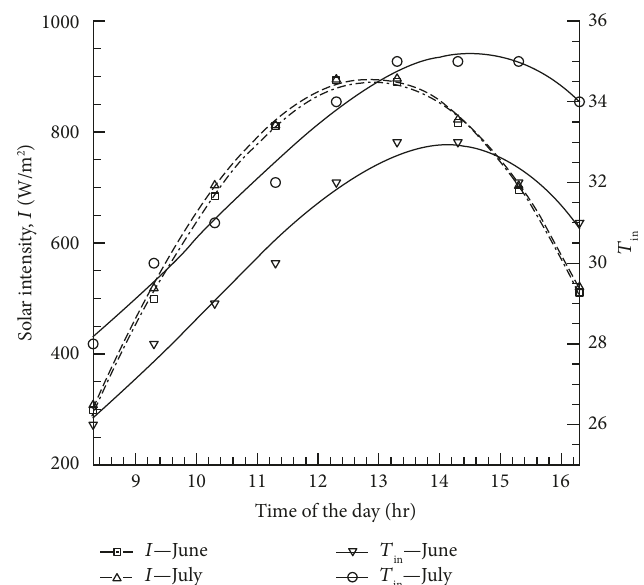
Figure 3: Mean hourly variation of solar intensity and ambient